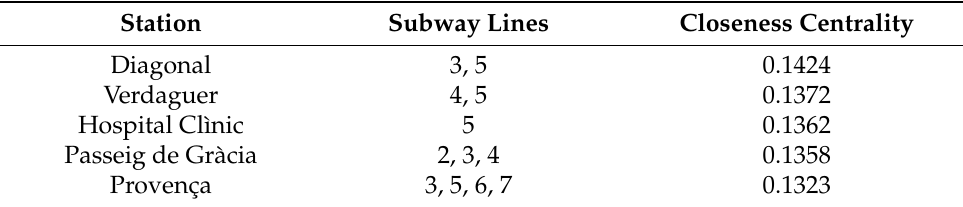
Table 2. The five stations with the highest closeness centrality. Station